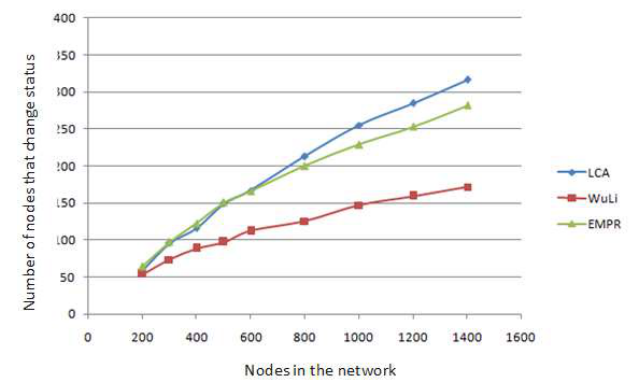
Figure 6. The average number of nodes that change status in a